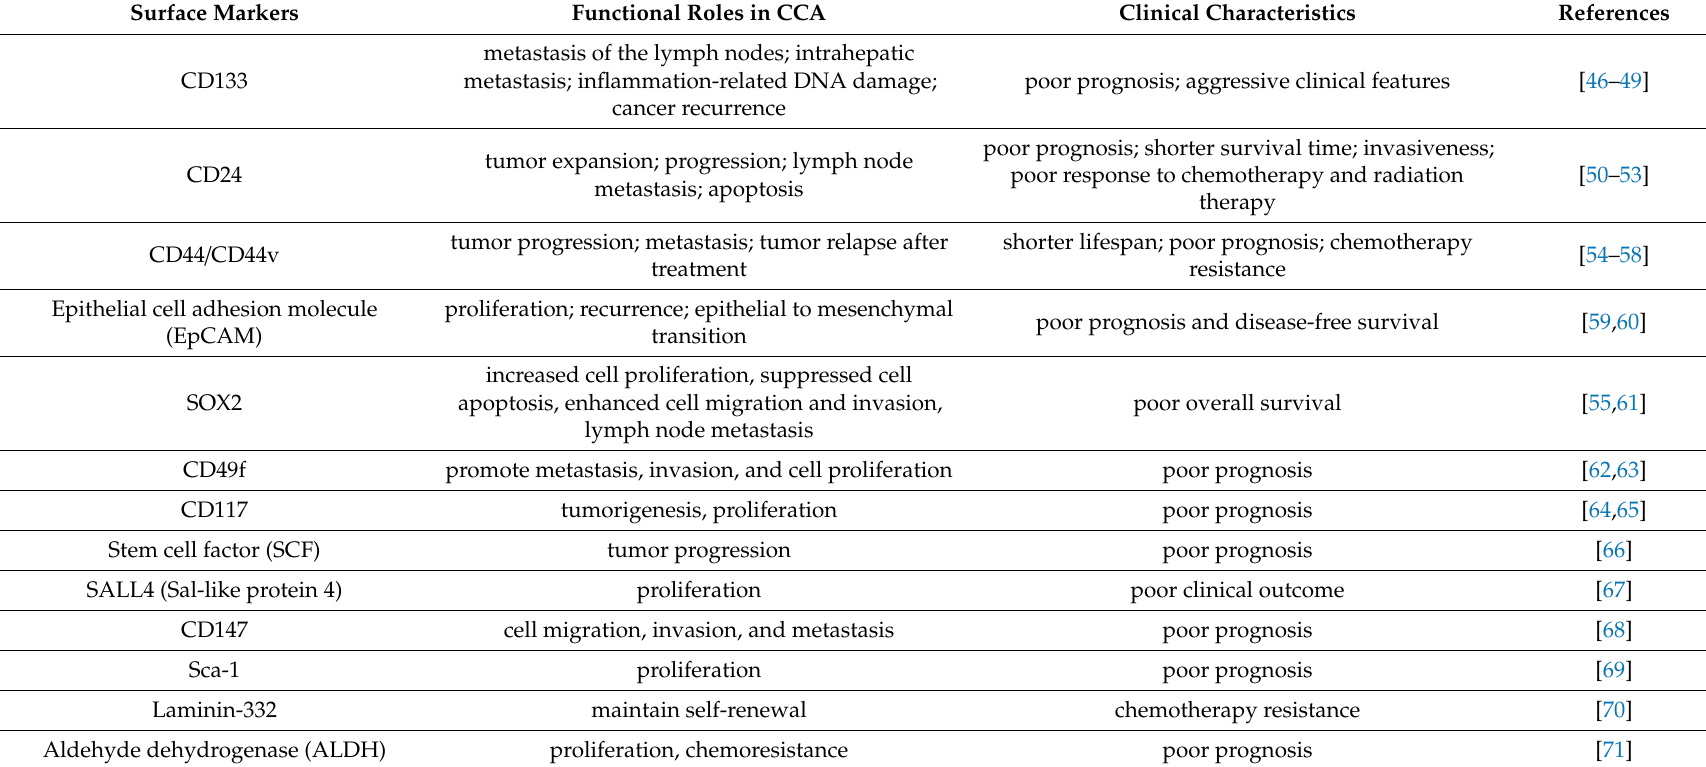
Table 1. Surface Markers of Cancer Stem Cells in Cholangiocarcinoma